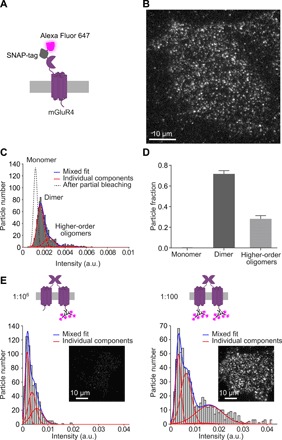
Analysis of mGluR4 stoichiometry by single-molecule microscopy.(A) Schematic view of the mGluR4 construct carrying an N-terminal SNAP-tag (SNAP-mGluR4), which was used for the analysis. The construct was transiently expressed in CHO cells at low densities, corresponding to 0.45 ± 0.08 (SD) fluorescently labeled mGluR4s/μm2, and labeled at 1:1 stoichiometry with a saturating concentration of an Alexa Fluor 647 benzylguanine derivative, which binds covalently and irreversibly to the SNAP-tag. Cells were sequentially fixed and imaged by TIRF microscopy. (B) Representative TIRF image of a fixed CHO cell expressing the SNAP-mGluR4 construct. Dots represent individual receptor particles, which were identified with an automated single-particle detection algorithm. (C) Representative distribution of the intensity of mGluR4 particles in a cell expressing the SNAP-mGluR4 construct. Data were fitted with a mixed Gaussian model. The result of a mixed Gaussian fitting after partial photobleaching (dotted black line) was used to precisely estimate the intensity of single fluorophores in each image sequence. a.u., arbitrary units. (D) Relative abundance of monomers, dimers, and higher-order oligomers or nanoclusters detected by the analysis. Data are means ± SEM of 11 cells from three independent experiments (12,012 particles). (E) Estimation of the number of primary antibodies binding to one mGluR4. CHO cells transiently transfected to express wild-type mGluR4 at low densities—0.55 ± 0.07 (SD) fluorescently labeled mGluR4s/μm2—were incubated with either a limiting dilution (1:106) or a saturating concentration (1:100) of the primary antibody against mGluR4 and labeled with an Alexa Fluor 647–conjugated secondary antibody. Cells were then imaged and analyzed as in (B) and (C). Representative images and results of 20 (17,257) and 22 (13,553) cells from three independent experiments, respectively (number of particles in brackets), are shown.